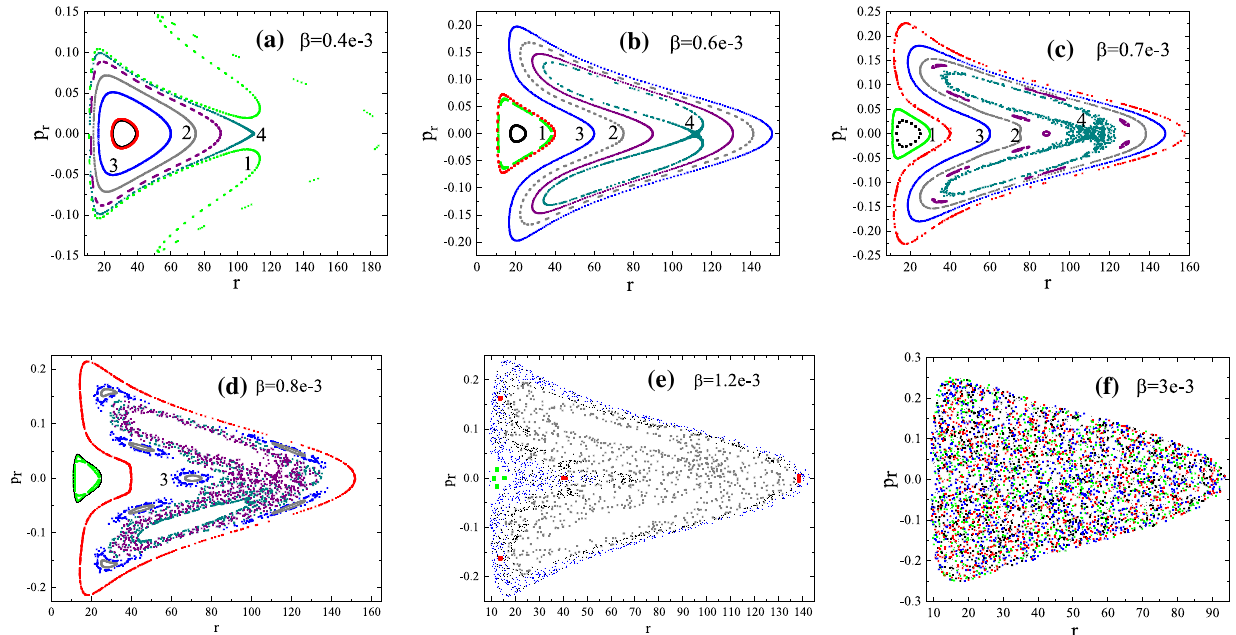
Fig. 2 Same as Fig. 1b, but for different values of the magnetic parameter β . An increase of β results in strengthening the extent of chaos. Orbit 3 with the initial separation r 0 = 60 in panel ( d ) is weakly